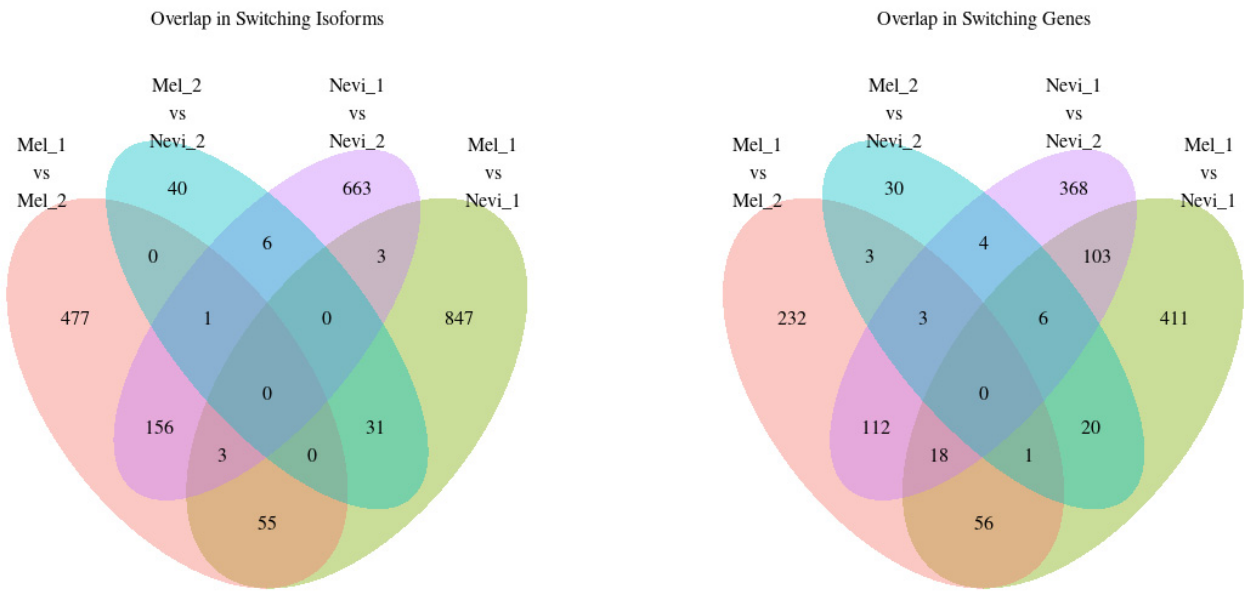
Figure 4. Overlap of splice switching isoforms and splice switching genes. Venn diagrams were generated for differentially expressed splice variants and spliced genes.